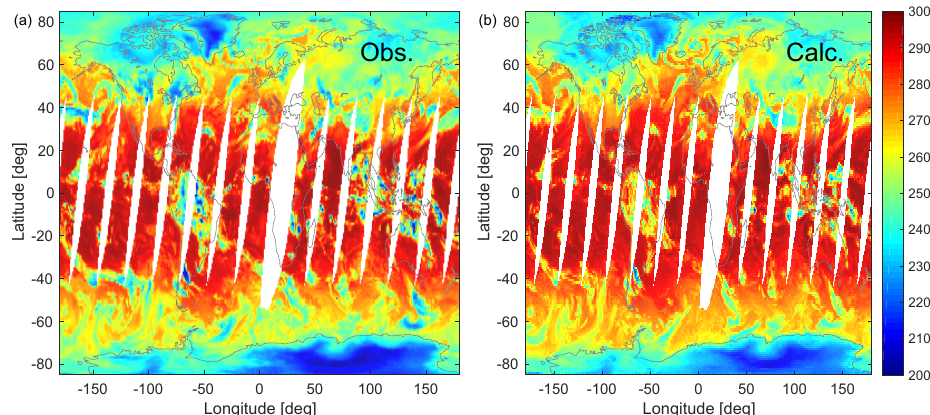
Figure 4. (a) AIRS 1231cm − 1 channel brightness temperatures (in K) for the descending node (night) on 11 March 2011, using a 1 degree grid. (b) Computed BT 1231 using SARTA–TwoSlab. Note the excellent agreement between the observations and calculations – there are large areas in the tropics with ∼ 0K differences. Careful examination (of obs.–calc.) does reveal large negative and positive biases scattered throughout due to spatial mismatches in the model versus observed clouds, for example the tropical west Pacific (see Fig. 5) and the Amazon.